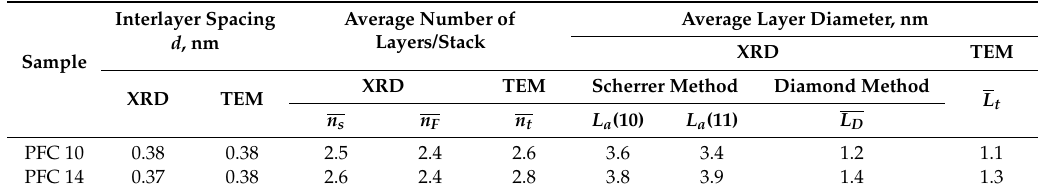
Table 2. Comparison of structural parameters for phenol-formaldehyde-based carbon heat-treated at 1000 ◦ C and 1400 ◦ C from XRD and TEM techniques. Reproduced with permission from Sharma et al. [78]. Copyright Elsevier,